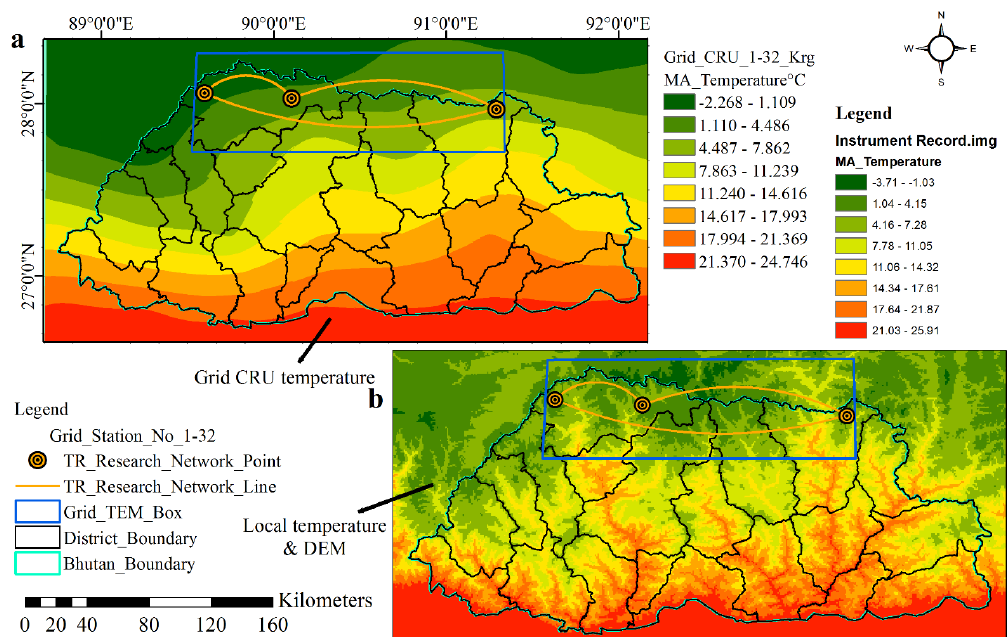
Figure 4. Interpolation of 32 gridded CRU mean annual temperature (( a ), mean of 1970 – 2016) and local instrumental mean annual temperature (( b ), vary from 10 to 24 years of means from different stations) over Bhutan and neighbor regions. Tree-ring network and three treeline sites (golden con- centric circles connected by thick curved lines inside blue box). 32 Gridded CRU stations with mean annual temperature (1970 – 2016) is labelled as Grid_CRU_1 − 32 ( a ) and local observed temperature is labelled as Instrument Record ( b ). Blue box shows locations of six CRU grids 19, 27, 20, 28, 21, and 29 that were used as representative climate variables (NBGridTEM-6) for reconstruction.